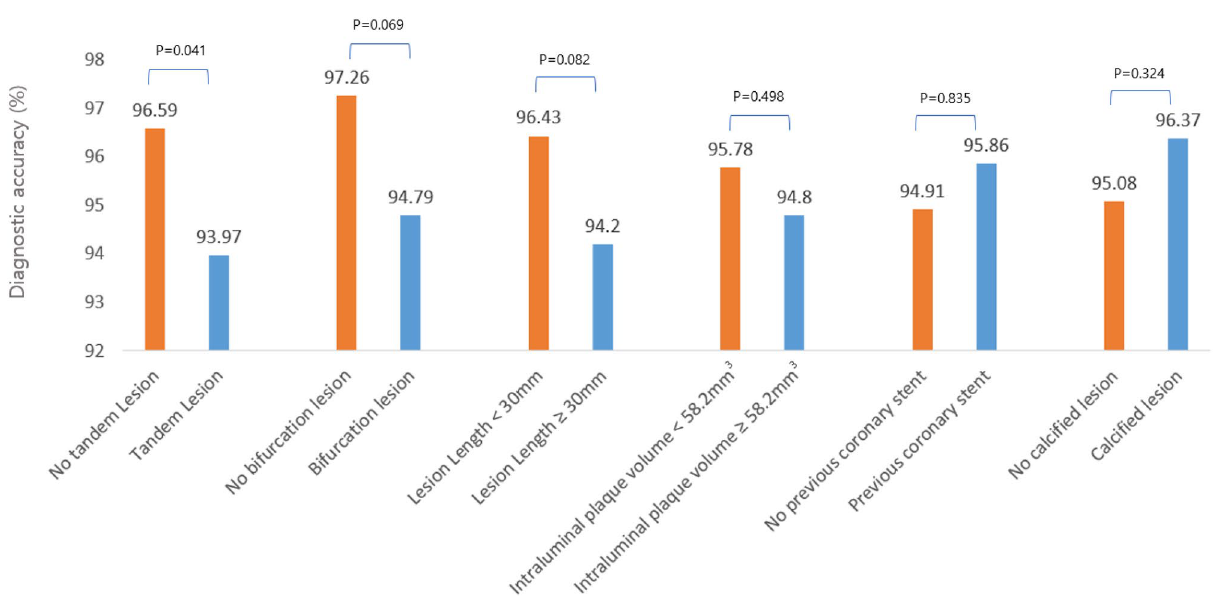
Figure 4. Diagnostic performance of QFR against FFR in different subgroups of complex lesions. The diagnostic accuracy of QFR measured in vessels with tandem lesions was significantly lower than in vessels with single lesions. P values were calculated using the chi-square test or Fisher’s exact